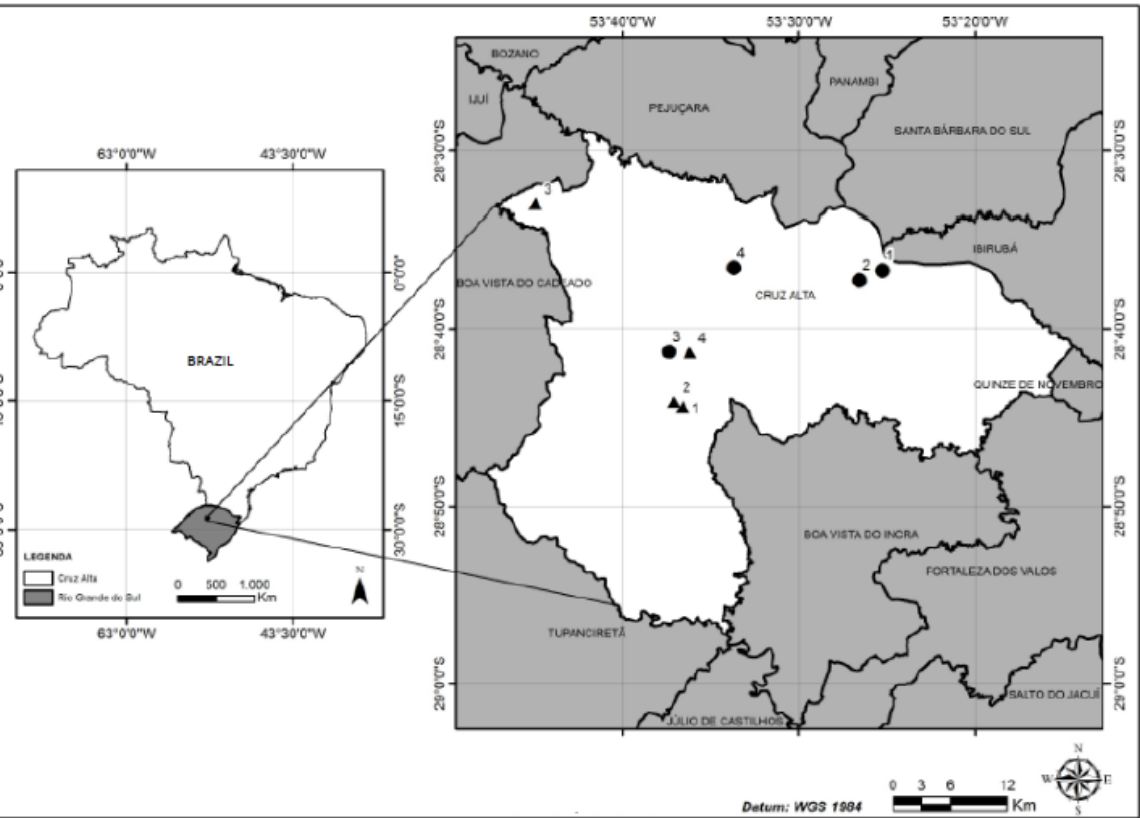
Figure 1. Geographic location of the study area and distribution of sample points. Circles represent inserted ponds and triangles represent adjacent